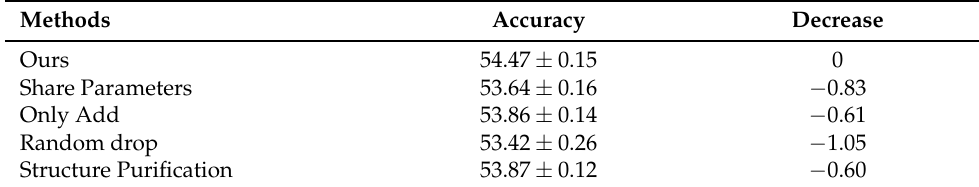
Table 7. Results of detailed analysis of heterogeneous structure purification module on OGB-MAG. “Share Parameters” means we reuse the attention scores as filter scores. “Only add” means we add filter scores on attention scores without truncation. “Random drop” means we drop edges at random with a probability of